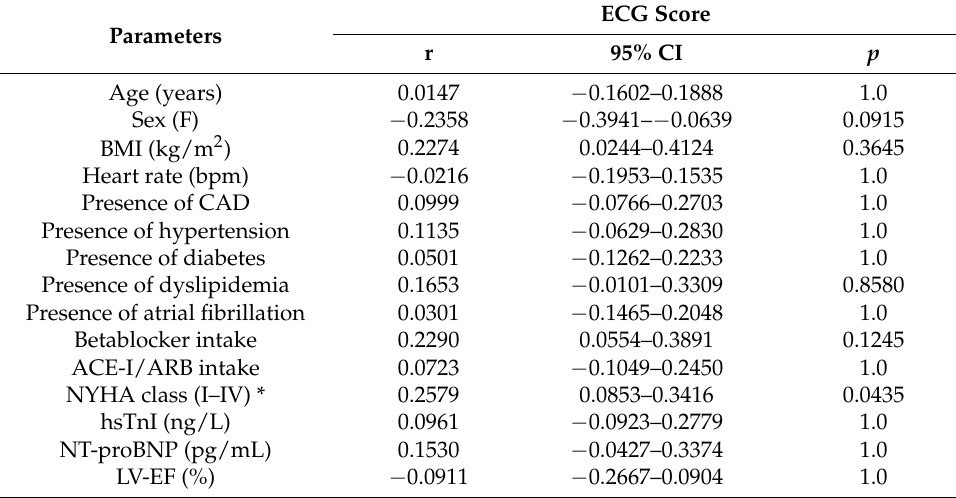
Table 5. Spearman rank correlation